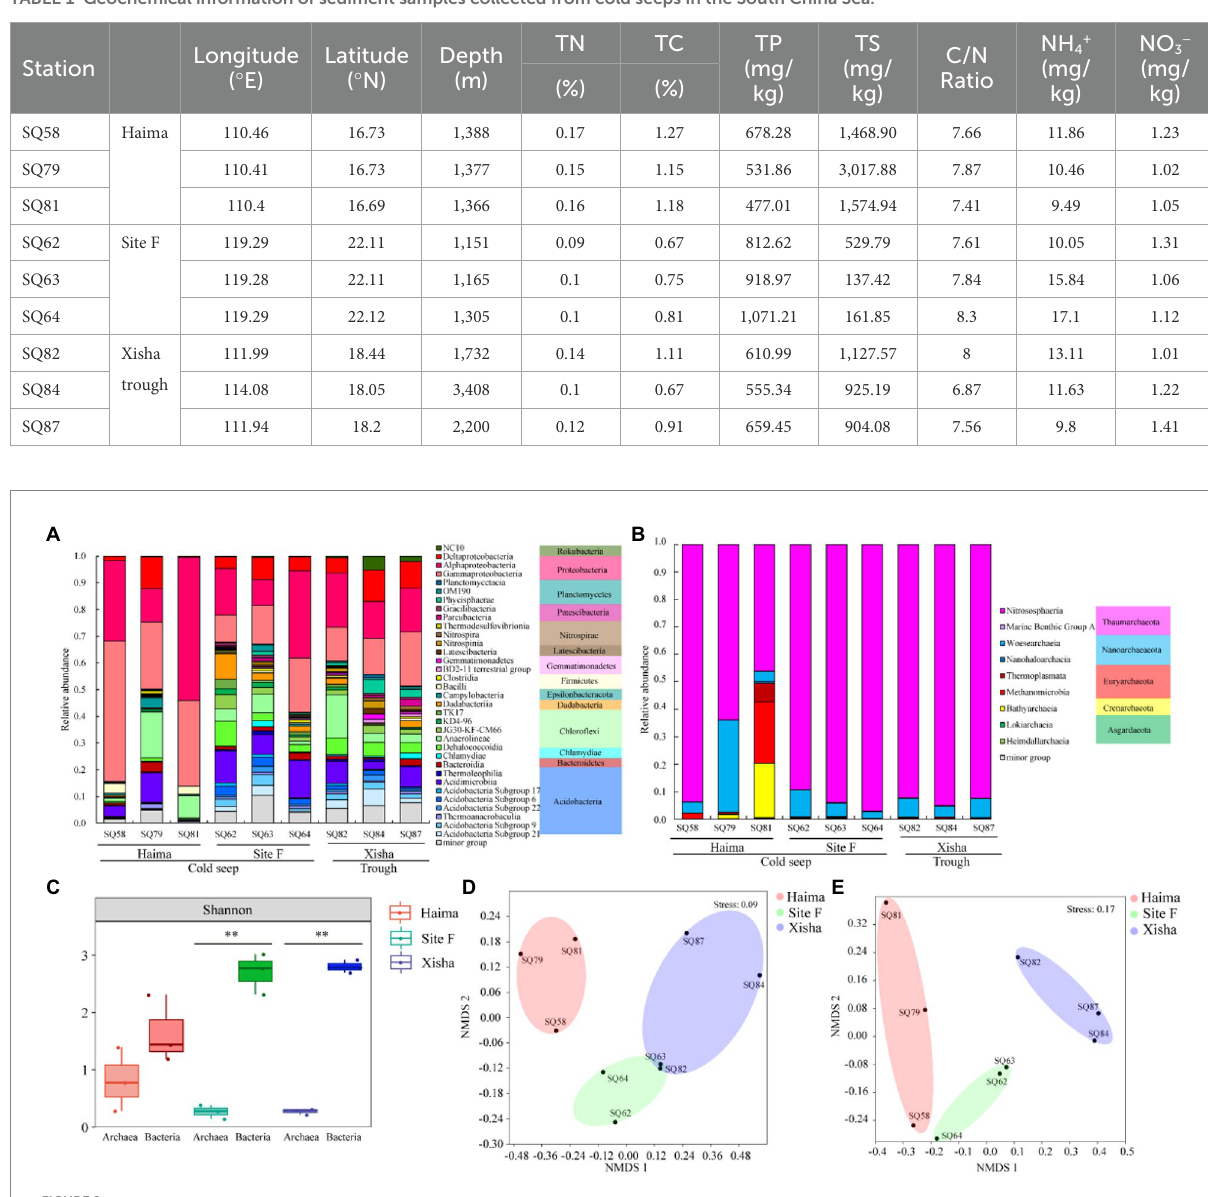
FIGURE 2 Community composition of bacteria (A) and archaea (B) at the class level; Averaged alpha diversity indices of the bacterial and archaeal communities based on 16S rRNA gene (**: p < 0.01) (C) ; non-metric multidimensional scaling (NMDS) plots of bacterial (D) and archaeal (E) communities based on 16S rRNA